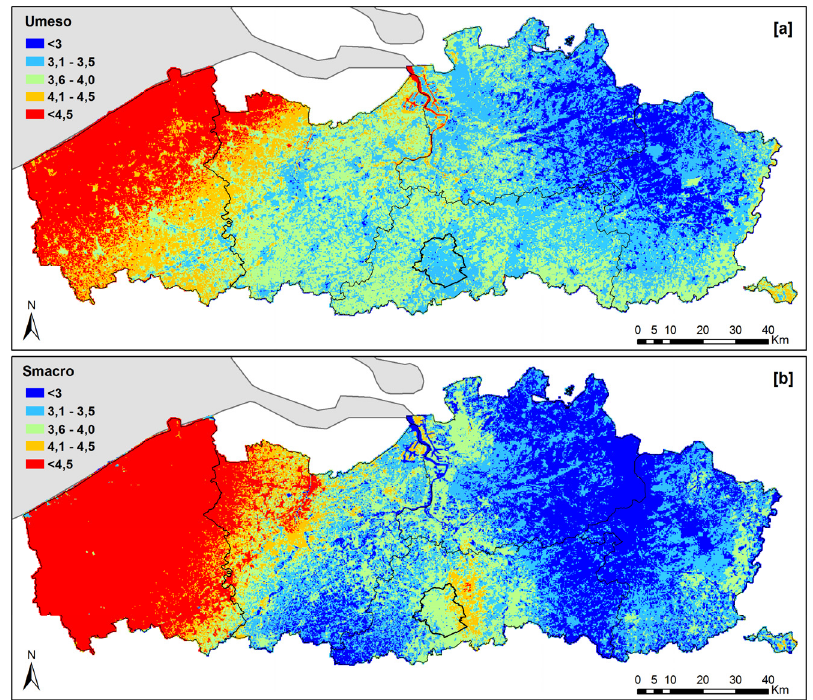
Figure 4. Yearly mean surface wind speed generated using the mesowind method and the